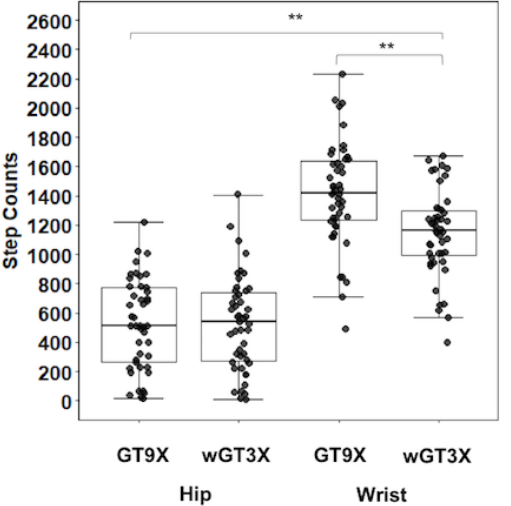
Figure 2. Average step counts. Box plot with scatter represents 25th percentile at bottom and 75th percentile at top with the highest, median, and lowest value. ** p < 0.001: higher steps in GT9X vs. wGT3X on the wrist; higher steps in wrist vs. hip.